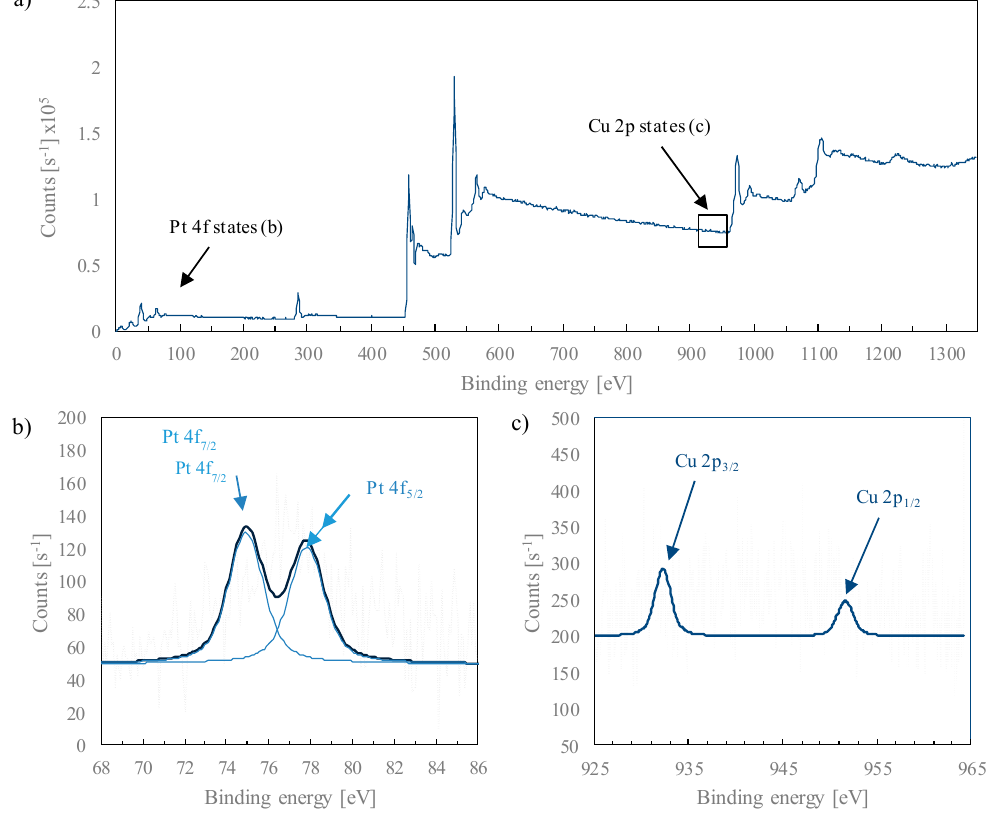
Figure 5. XPS spectra for d-TiO 2 _20-Pt0.1 / Cu0.1 sample ( a ) with the deconvolution for Pt 4f ( b ) and Cu 2p ( c ).